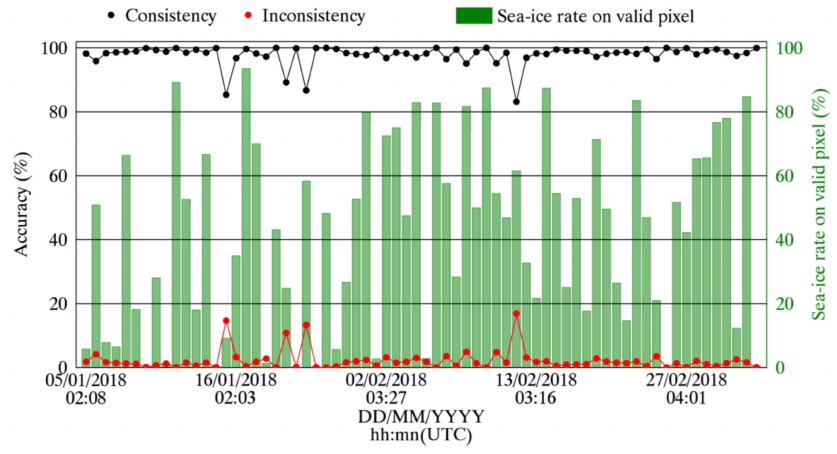
Figure 10. Time–series of consistency / inconsistency in the sea-ice data using GK-2A / AMI sea-ice detection algorithm than S-NPP / VIIRS SIC EDR data from January to March 2018, “sea-ice rate on valid pixel” means the distribution ratio of sea ice among all pixels of the S-NPP / VIIRS SIC Scene.